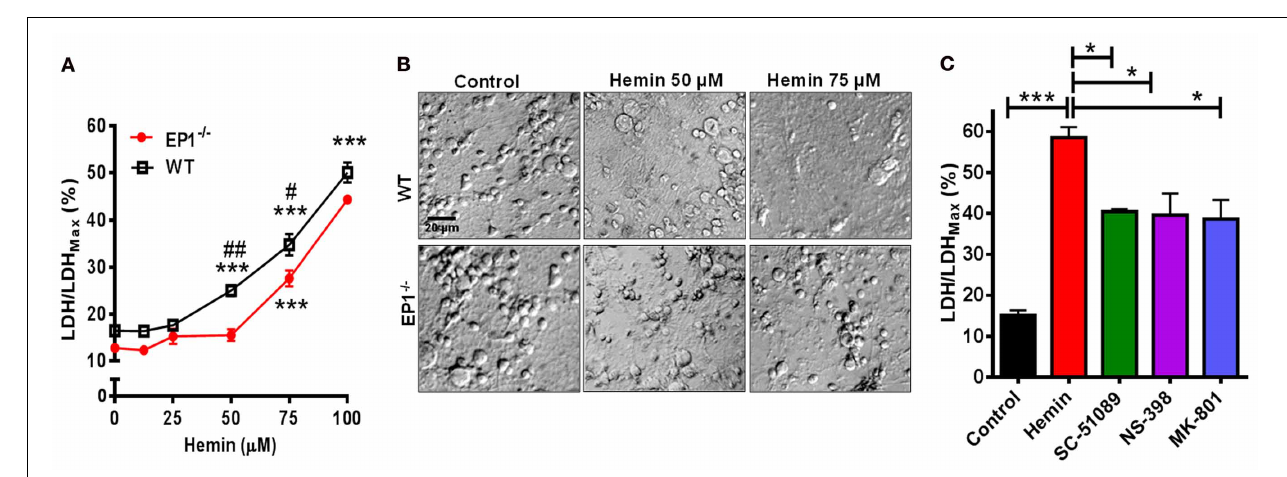
FIGURE 2 | EP1 receptor blockade and knockout reduces hemin neurotoxicity. Primary postnatal neurons from WT and EP1 − / − pups cultured in serum-free Neurobasal media were treated with hemin (12.5–100 μ M) for 18h. (A) Hemin-induced cell viability was measured by LDH assay [LDH/LDH Max %] from WT and EP1 − / − neurons. ∗∗∗ p < 0 . 001 vs. control; # p < 0 . 01 and ## p < 0 . 001 compared to the effect of hemin (50 and 75 μ M) in neurons cultured from EP1 − / − pups. (B) Cultured WT and EP1 − / − neurons were treated with vehicle control or hemin (50 and 75 μ M) for 18h and phase-contrast images were captured using a 20 ×